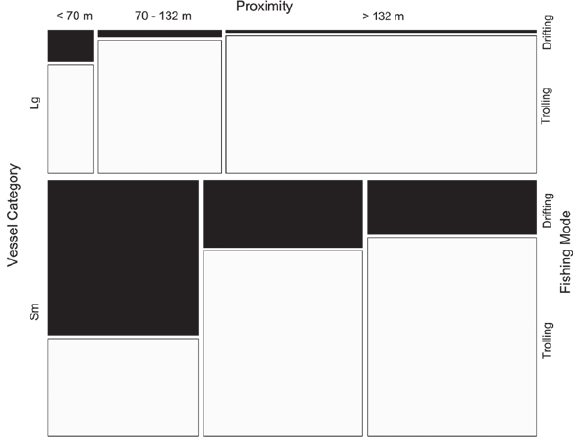
Fig. 5. – Cumulative association of vessel category, operation prox- imity and fishing mode to detected vessel presence at moored FADs off San Juan, Puerto Rico. The rectangle height determines the fre- quency of fishing mode association; width determines the frequency of operation proximity.